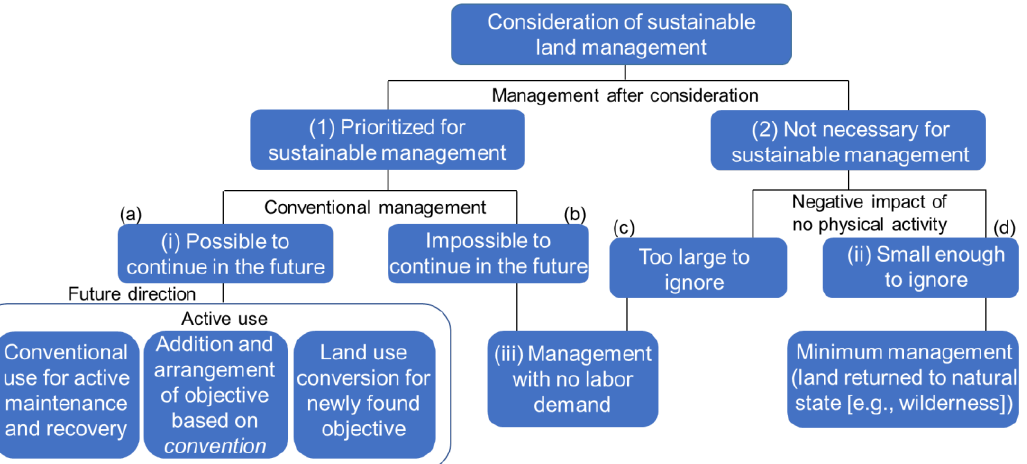
Figure 2. Development and planned implementation of the consensus-building mapping system to promote policies that balance agriculture and forestry production with environmental conservation. To achieve sustainable land management goals, croplands that are: (a) possible to manage in the future, (b) cannot be manage, (c) too large to ignore, and (d) small enough to ignore are identified (modified from